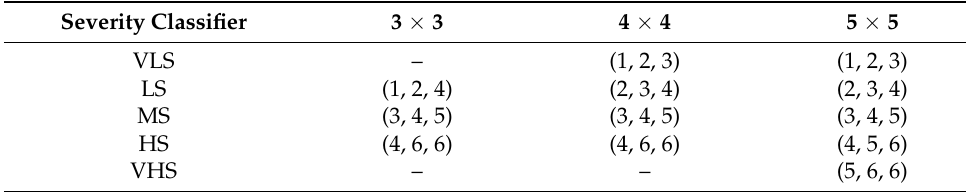
Table 1. Fuzzy membership of severity classes predicted by AutoML.